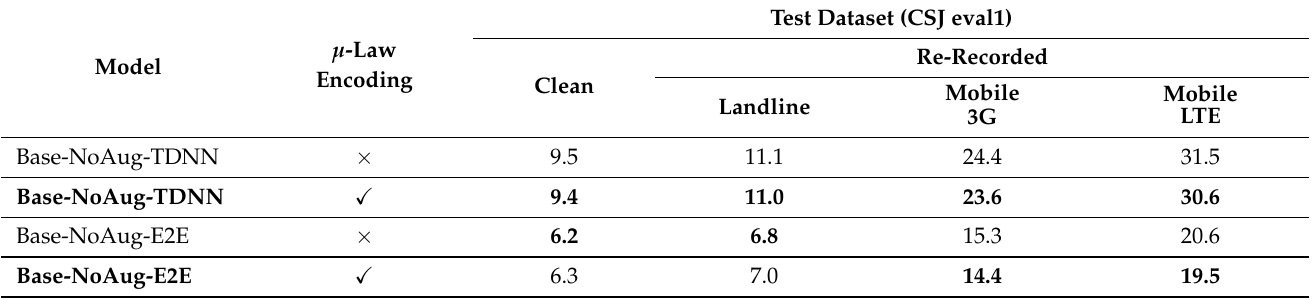
Table 4. Telephone speech: character error rate (CER%) of TDNN and E2E ASR models trained by data with or without µ -law encoding.The notation “ (cid:88) ” denotes “applied” and “ × ” denotes “did not apply”. The Expressions in bold font denotes the baselines models those are trained with µ -law encoding. The bold numbers represent the smallest word error rate comparing results between baselines with or without µ -law encoding for each category of ASR (TDNN or